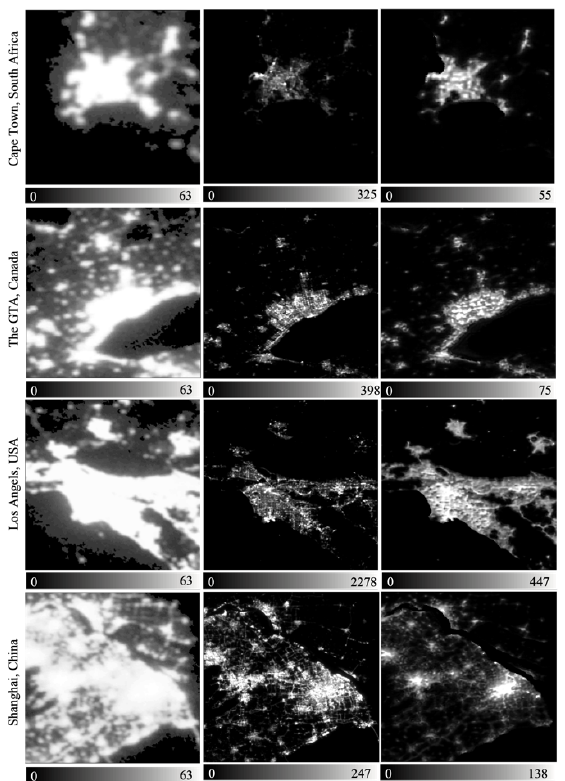
Figure 3. Visual comparison between predicted VIIRS-liked NTL images and DMSP and VIIRS NTL images in 2012.